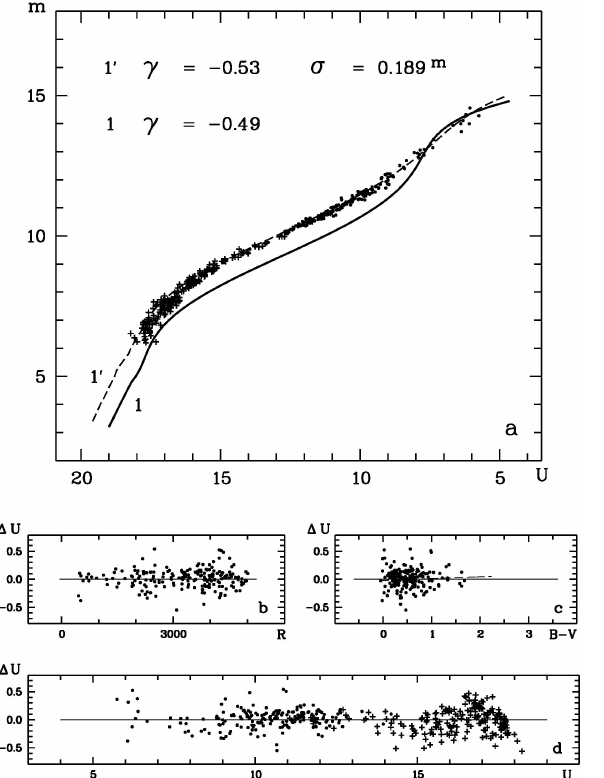
Figure 6. Characteristic curves for plates No. 1834 (1’) and No. 1809 (1), exposed in the U band at the 1.2 m baldone Schmidt telescope (panel a). In panels b, c, and d, a section of the characteristic curve 1’ for the distance from the center of the plate, relative to the color index B-V and along the magnitude U, respectively. Dots and crosses correspond to photoelectric and CCD measurements of stars.